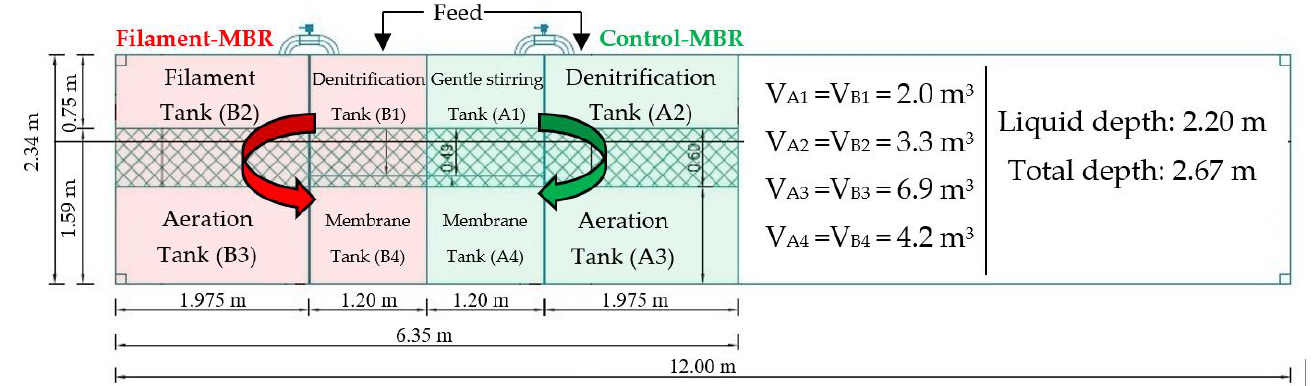
Figure 1. Top-view layout of the pilot-scale Membrane Bioreactor. Table 1. Applied operating conditions and membrane characteristics in pilot-MBRs.